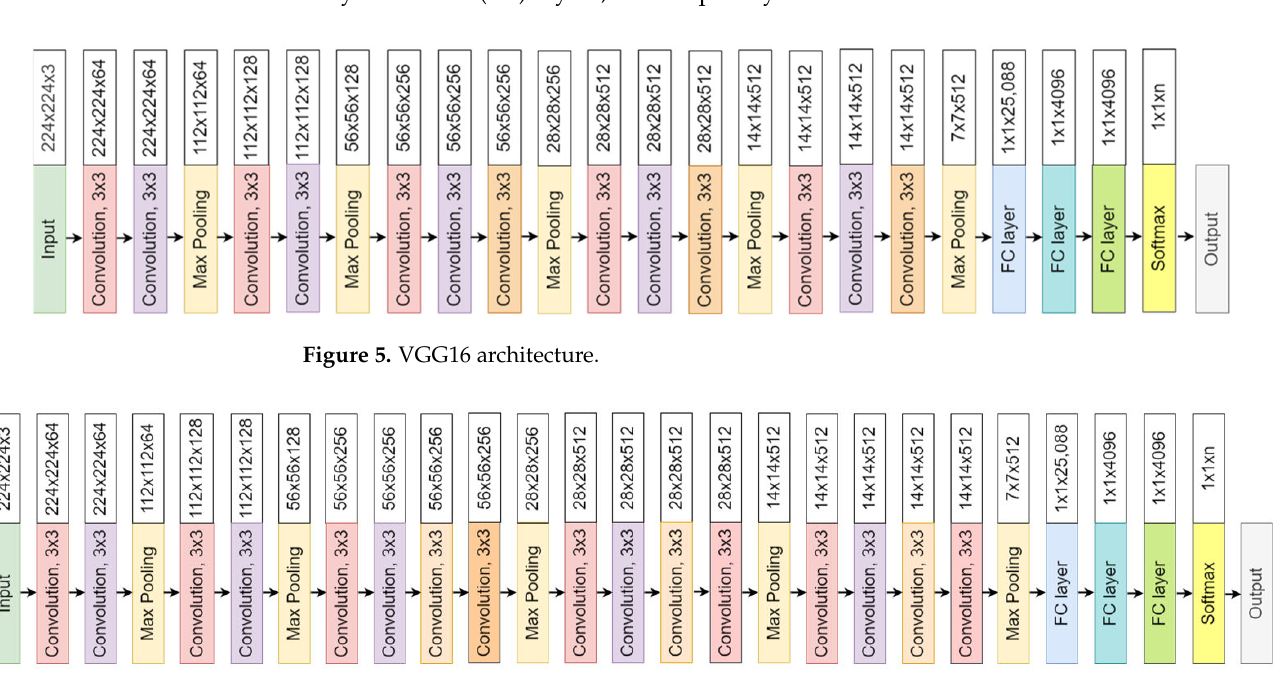
Figure 6. VGG19 architecture.